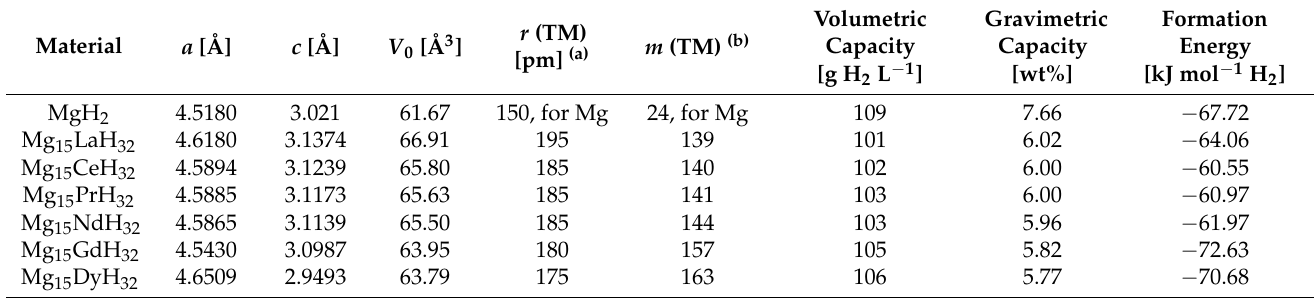
Table 1. Lattice parameters, unit cell volume, specific capacity, and formation energy of pure MgH 2 and doped MgH 2 , calculated from the density functional theory (DFT) study. Reprinted/adapted with permission from Refs. [122,124]. Copyright 2016,